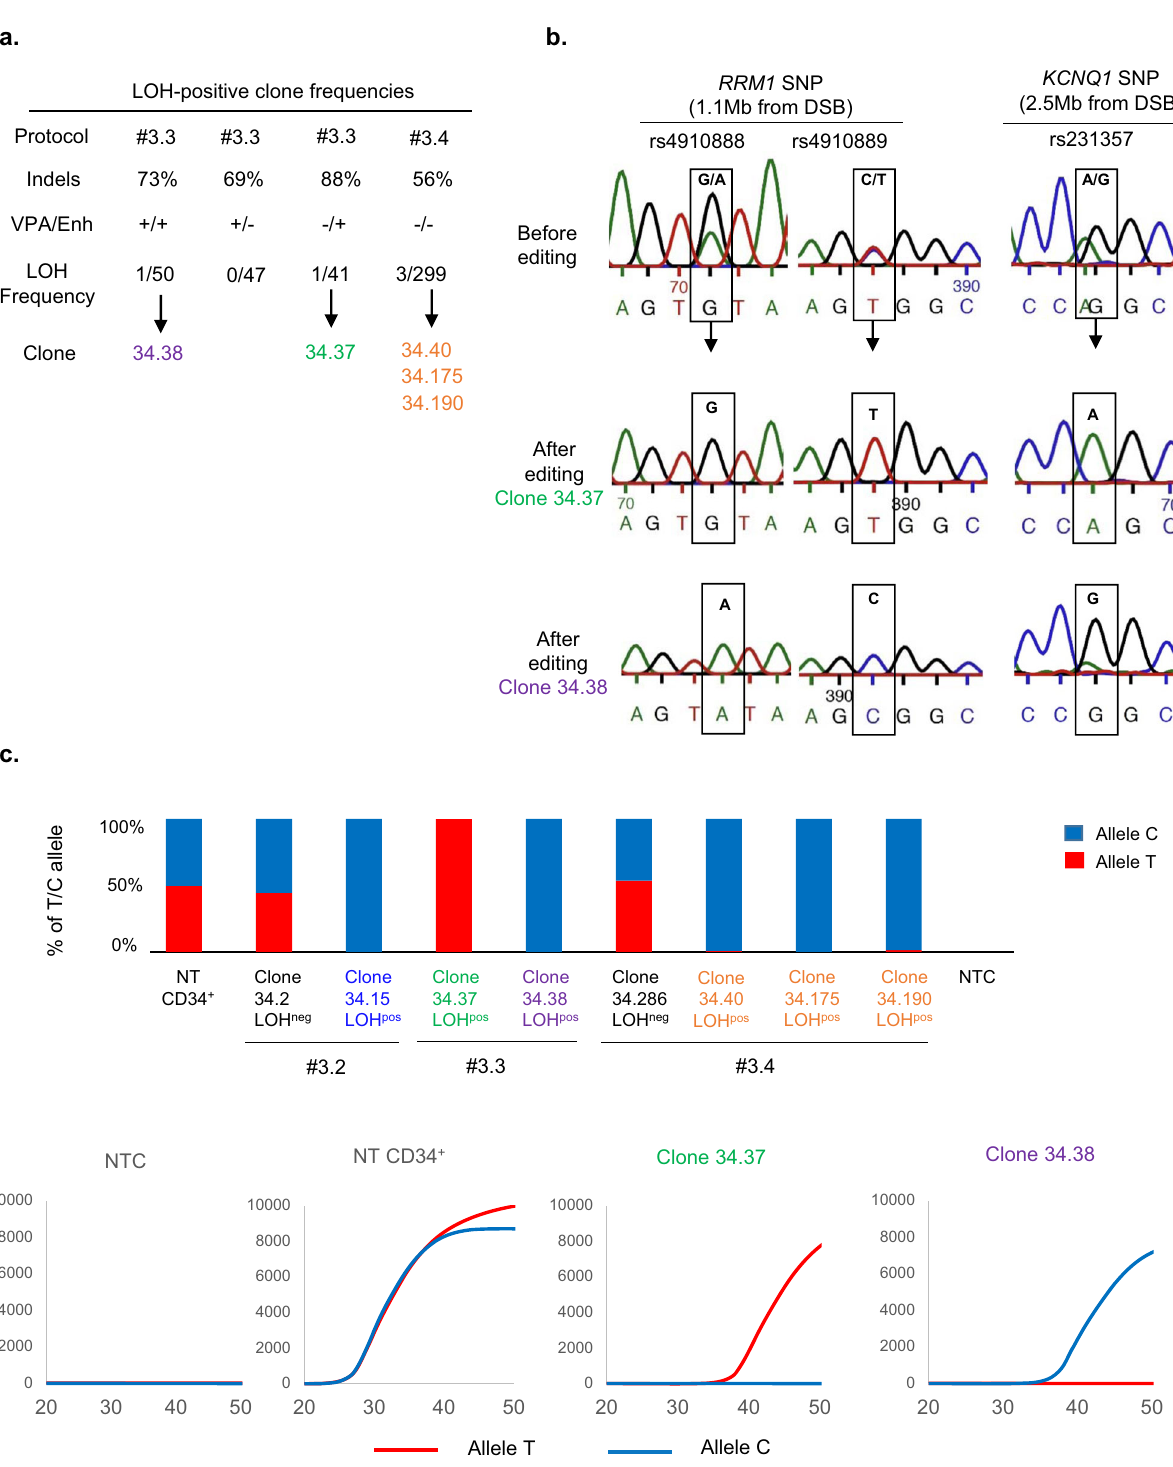
Fig. 4 CD34 + LOH clone presence is not dependent of VPA and enhancer. a LOH-positive clone frequencies in experiments with or without valproic acid (VPA) and transfection enhancer (enh). b Illustrative Sanger sequencing of 2 RRM1 SNPs at 1.1 Mb from the cut-site (rs4910888 and rs4910889) and KCNQ1 SNP at 2.5 Mb from the cut-site (rs231357). c Allele-speci fi c qPCR of RRM1 (rs4910889) to determine presence or absence of SNP with illustrative curves (low panel). Non-transduced CD34 + (NT), clone 34.2 and 34.286 without LOH are heterozygous with T/C alleles (allele C in blue and allele T in red). Presence of single allele revealed LOH in numerous clones. NTC, No template control. Source data are provided as a Source Data fi